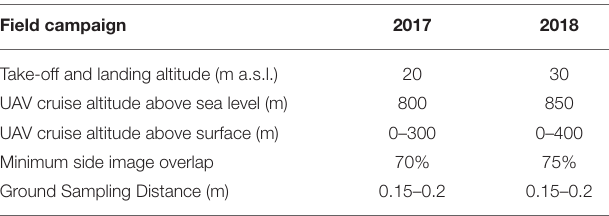
TABLE 1 | Flight and photogrammetrical settings used at Ingelfield Bredning in 2017 and Eqip Sermia in